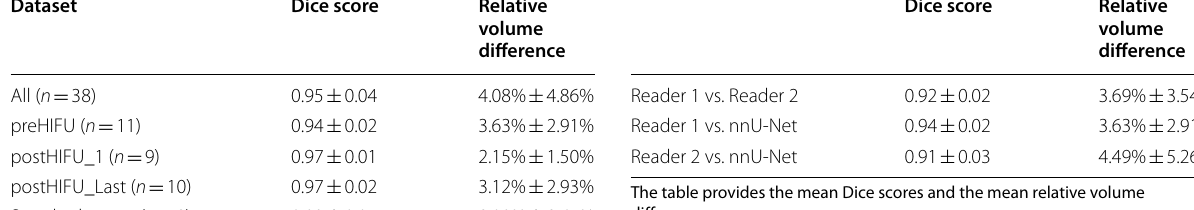
Table 4 Comparison of inter-reader agreement between the board-certified radiologist (reader 1) and the intensively trained radiology resident (reader 2) and the respective agreement of these readers with the predicted segmentations of the nnU-Net on the preHIFU data in the hold-out test set ( n 11) = Dice volume